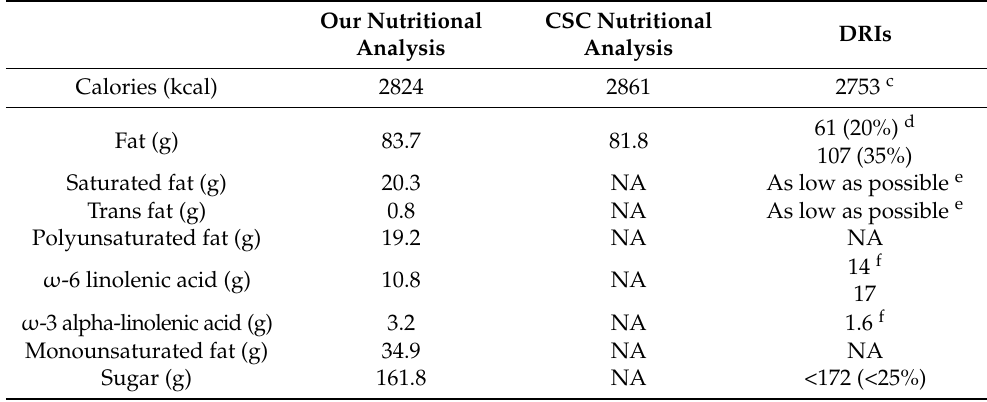
Table 2. Mean content per nutrient of our nutritional analysis compared to CSC’s internal analysis, CSC nutritional targets and current Canadian